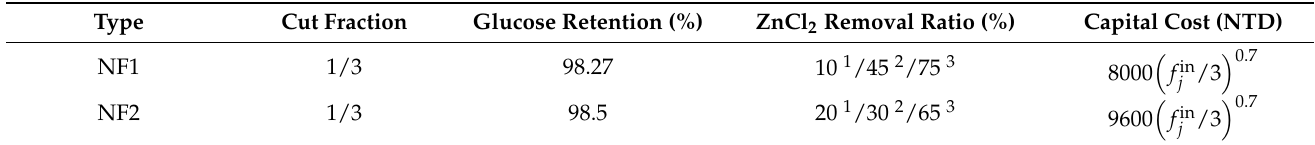
where β k is the base cost for a membrane unit of type k with an inlet flowrate of F ∗ . Table 1. Membrane performance and cost data for case